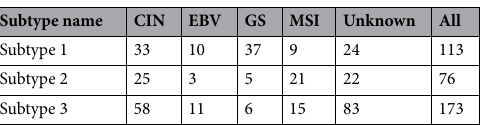
Figure 2. ( a ) Heatmap showing hierarchical clustering for the ECv matrix in the STAD dataset. ( b ) Heatmap showing hierarchical clustering for the RNA-seq matrix in the STAD dataset. ( c – e ) The distribution of (cid:31) ECv of edges and absolute log 2 fold change in genes in the STAD dataset (See supplementary S2.3). Dashed lines represent of the top 1.0% of the total edges in every subtype. ( f ) The Venn diagram represents the number of edges in the STAD dataset. Colored areas in the Venn diagram represent subtype-specific edges in each subtype.